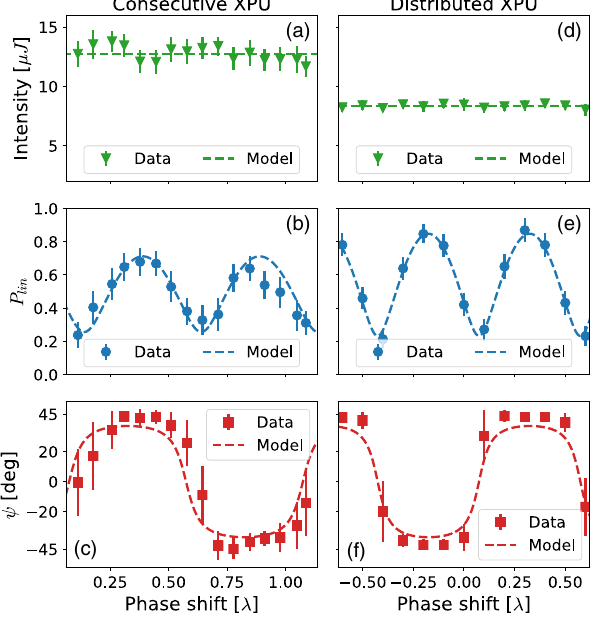
FIG. 12. Scan of the phase between LV and LH crossed polarized fields. The degree (b, e, blue) and direction (c, f, red) of the linear polarization vector are reported as a function of the phase between the two fields, together with the intensity of the FEL radiation (a, d, green). Experimental data (markers) and Gaussian propagation model predictions (dashed lines) are reported for the consecutive (a, b, c) and the distributed (d, e, f) schemes. The model was obtained using a set of parameters obtained by the gain curve measurements for the intensity of the fields and the electron beam size measurements for the waist sizes of the sources. The consecutive scheme was obtained using 4 undulators in LV polarization and 2 in LH, while the distributed scheme was implemented using alternating polariza- tion